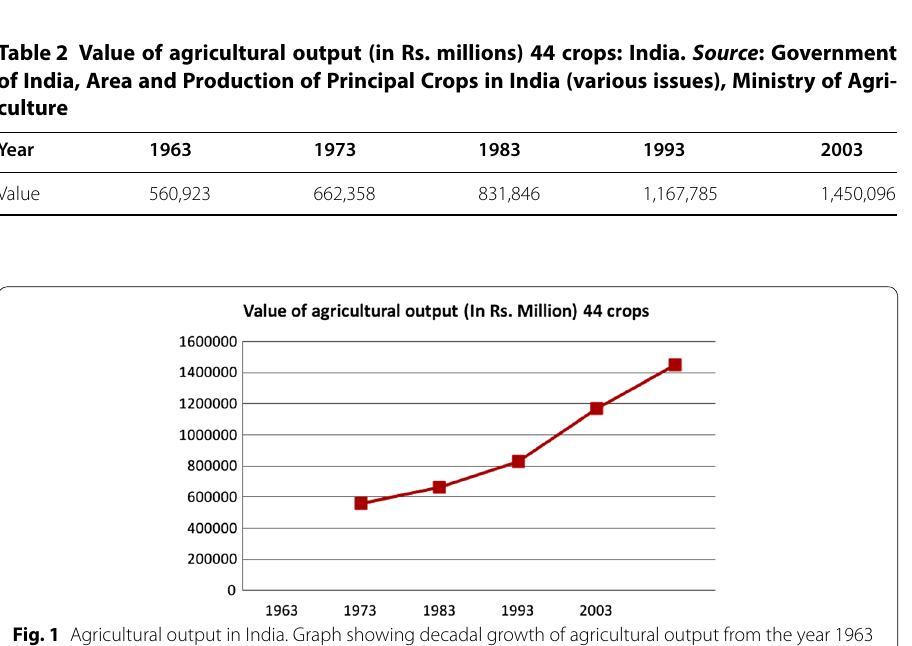
Census of India, 2000